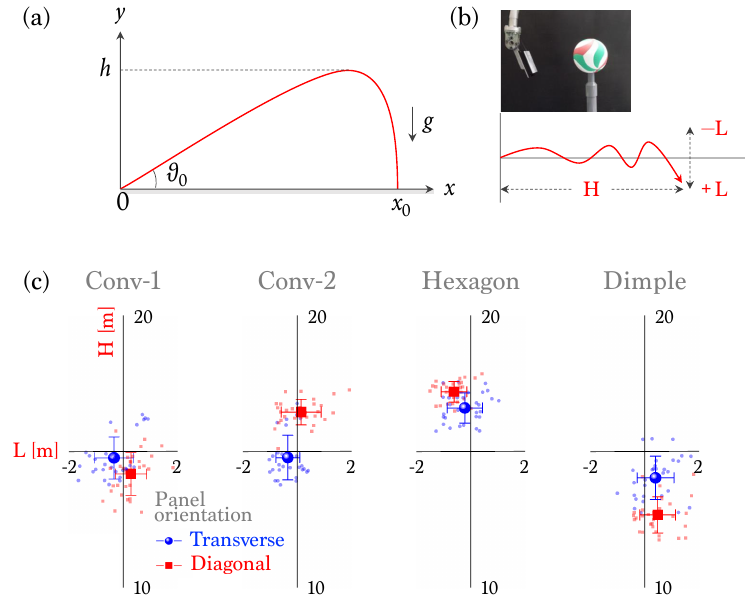
Figure 3. Flight characteristics of volleyballs. ( a ) An illustration for flight trajectory. ( b ) Lateral (L) and horizontal (H) flight distances were measured from the landing position experiment using a hitting robot. ( c ) All data of lateral and horizontal distances are summarized. Each panel with equidistant intervals is depicted at the same range of ± 2 m (lateral) and from 10 to 20 m (horizontal). Blue and red represents transverse and diagonal directions, respectively. Big circles and squares are the average values with error bars taken from the standard